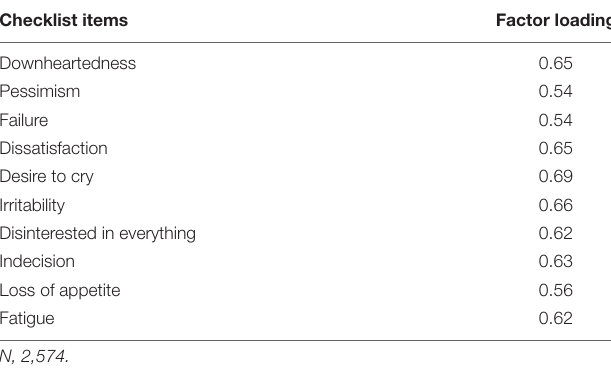
TABLE 3 | Negative emotions checklist items and factor loading.